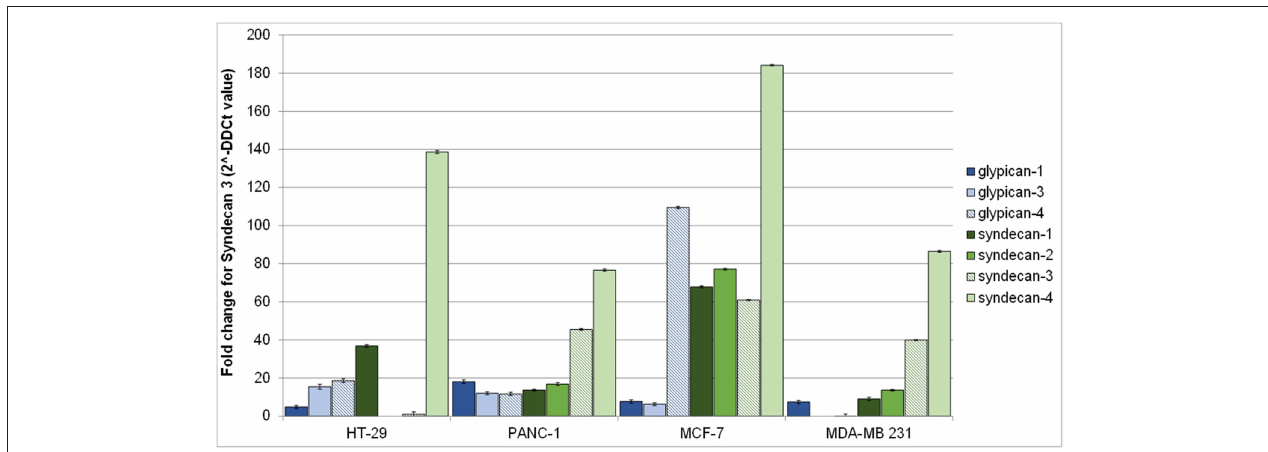
FIGURE 2 | Gene expression of human glypicans (shades of blue) and syndecans (shades of green) in HT-29, PANC-1, MCF-7, and MDA-MB-231 human cancer cell lines determined by qRT-PCR and normalized against β -actin. Results are reported as fold change for syndecan-3 in HT-29.